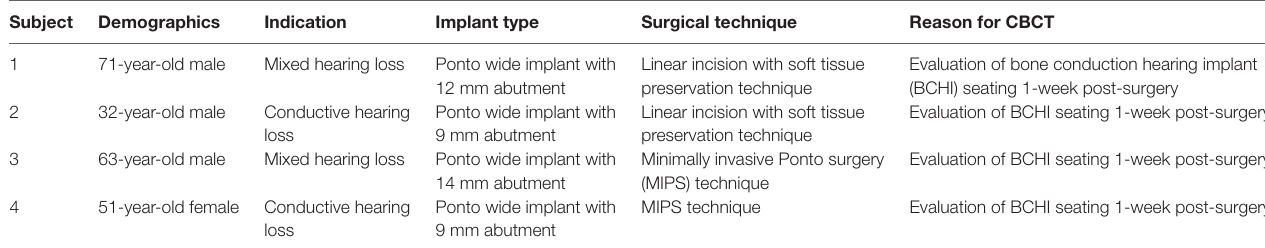
TABle 3 | Subject characteristics and cone beam CT (CBCT) imaging